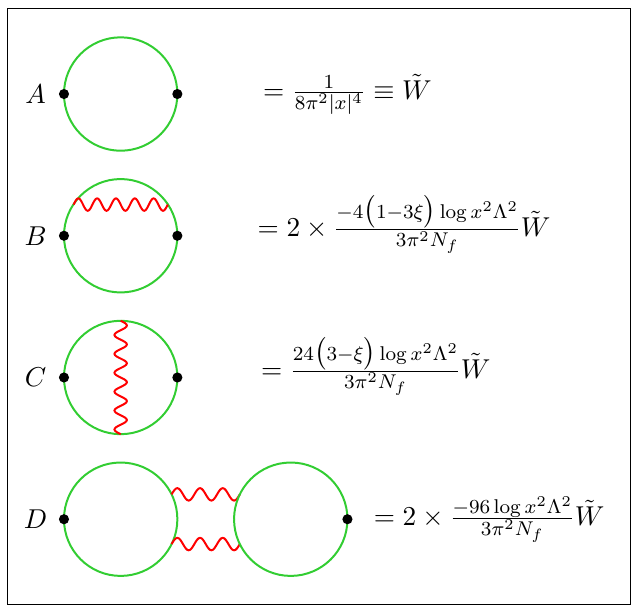
Table 9 . (fQED) Results for individual Feynman graphs appearing in the 2-point correlation function for the fermion-bilinear